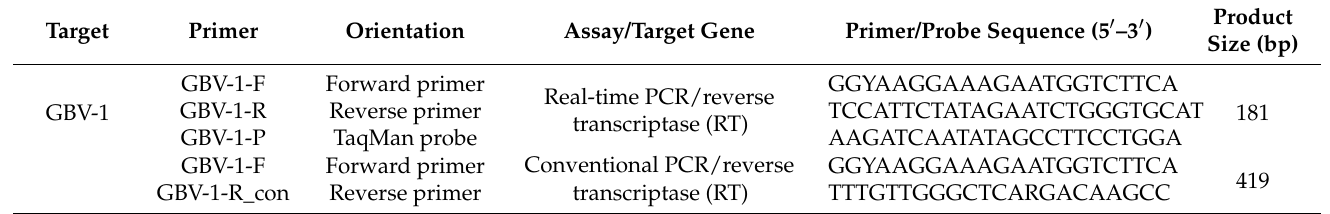
Table 1. Primers and probes used for grapevine badnavirus 1 (GBV-1) detection in real-time and conventional PCR